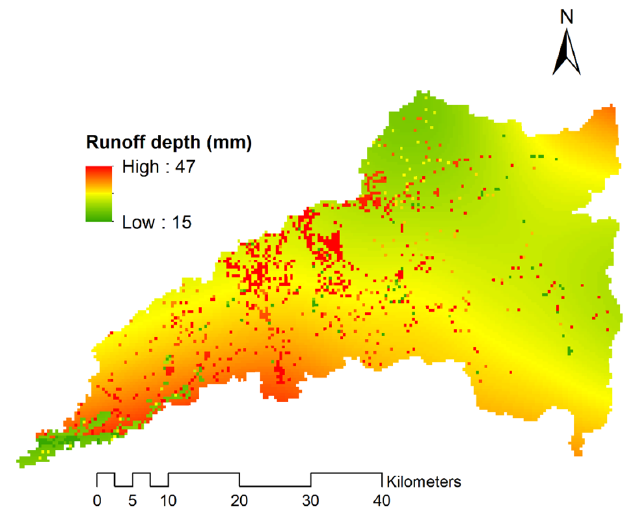
Figure 13. Potential runoff map of the study area.